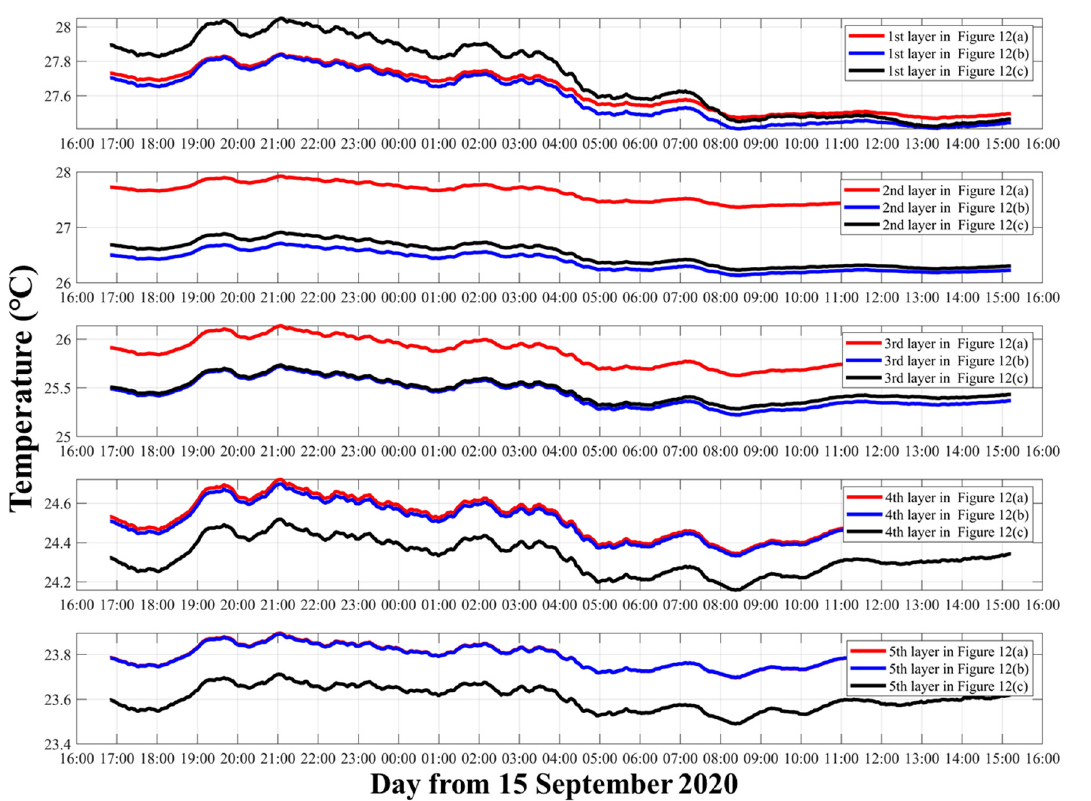
Figure 13. Moving average of five layers’ temperature. The red, blue, and black curves indicate five layers’ temperatures corresponding to Figure 11a–c, respectively.